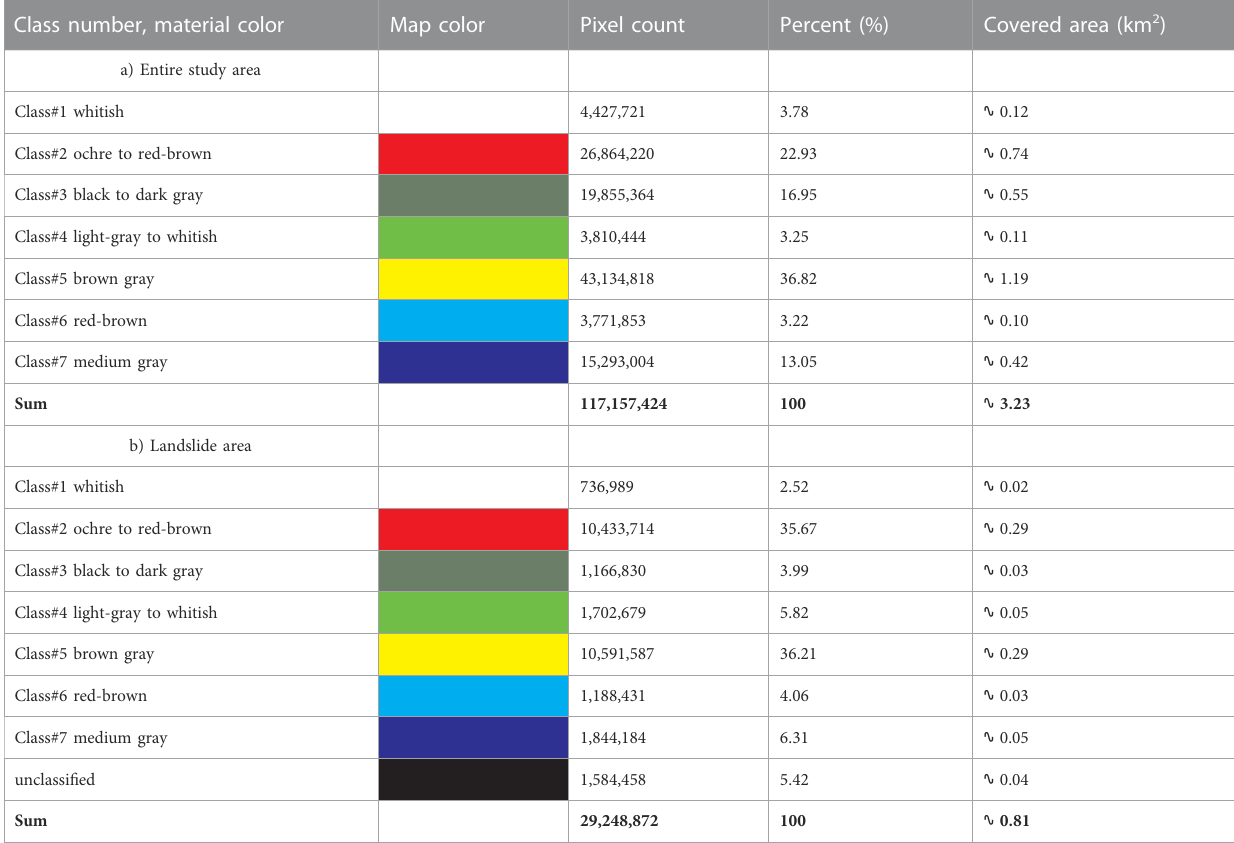
TABLE 1 Areal Statistics of Classi fi cation Results for a) the entire study area and b) the onshore portion of the landslide